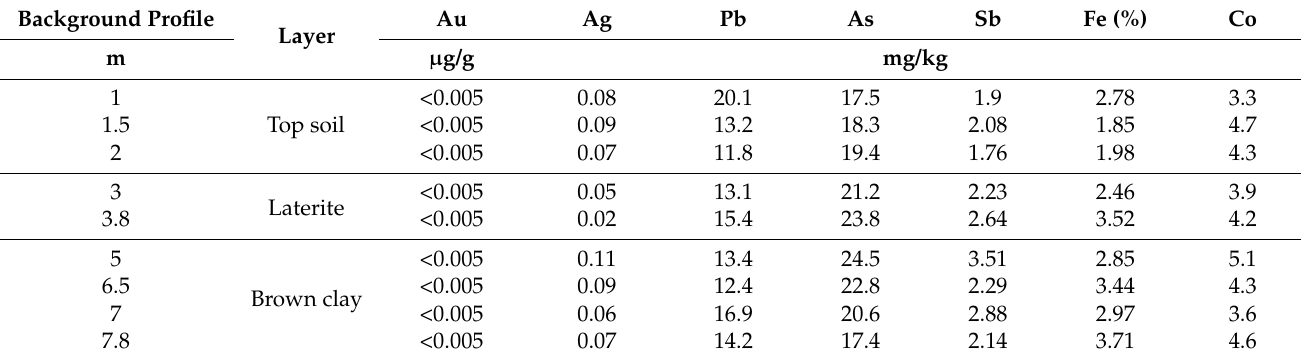
Table 2. The elements concentration of background